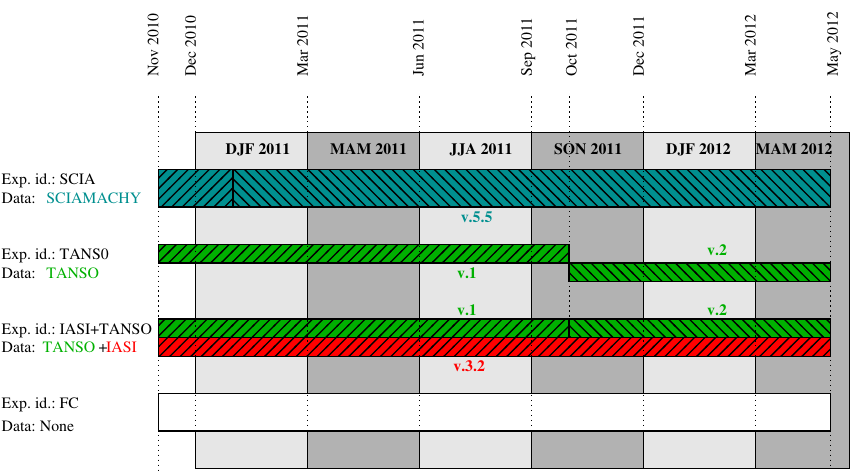
Figure 1. Configuration of the experiments. Each line represents an experiment and the box represents the timeline when the experiment was run. The name of the experiment is given by “Exp. Id.”. The assimilated data is given by “Data”. The text near the boxes is the version of the data that were